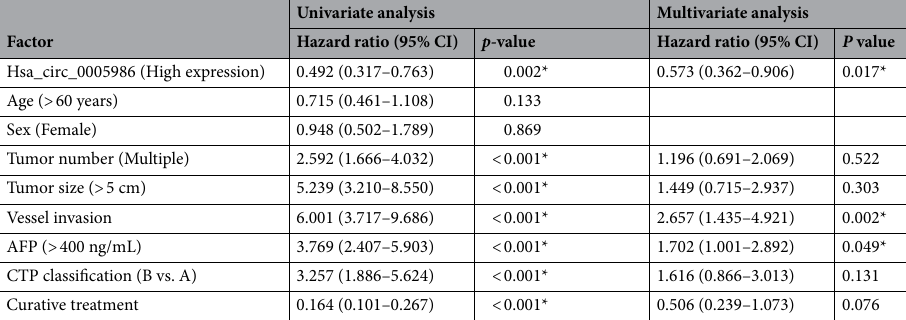
Table 4. Prognostic factors for progression-free survival in univariate and multivariate analyses. CI confidence interval; AFP alpha-fetoprotein; CTP Child–Turcotte–Pugh. * p < 0.05.